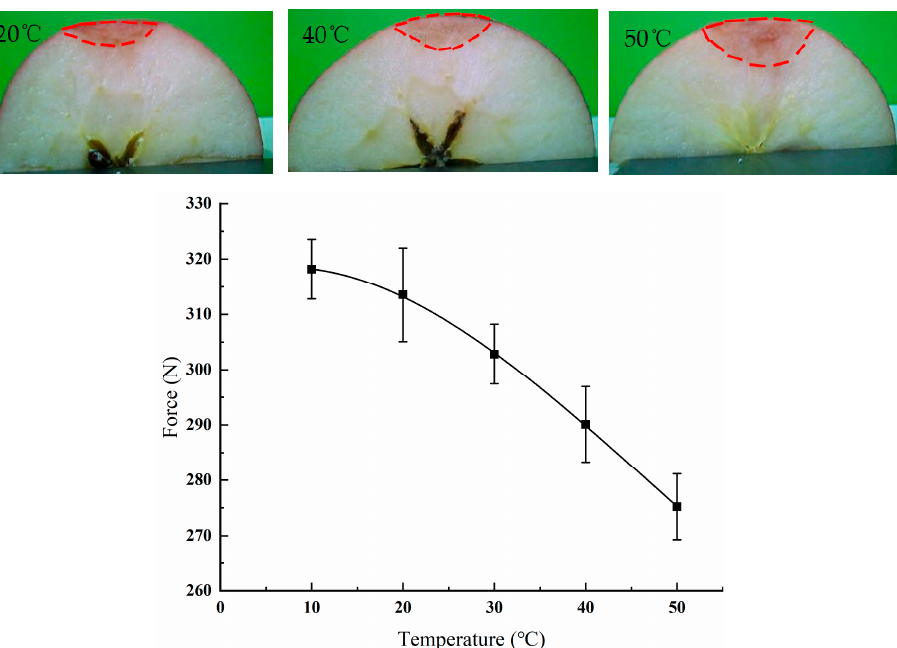
Figure 9. Peak force–temperature curve, and apple damage morphology at temperatures of 10, 20, 30, 40, and 50 °C.